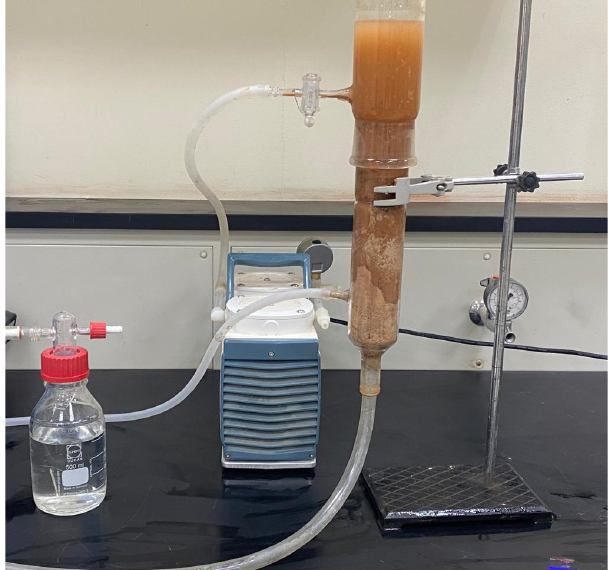
Figure 3. Showing the set-up of a fi xed bed for the experiments.